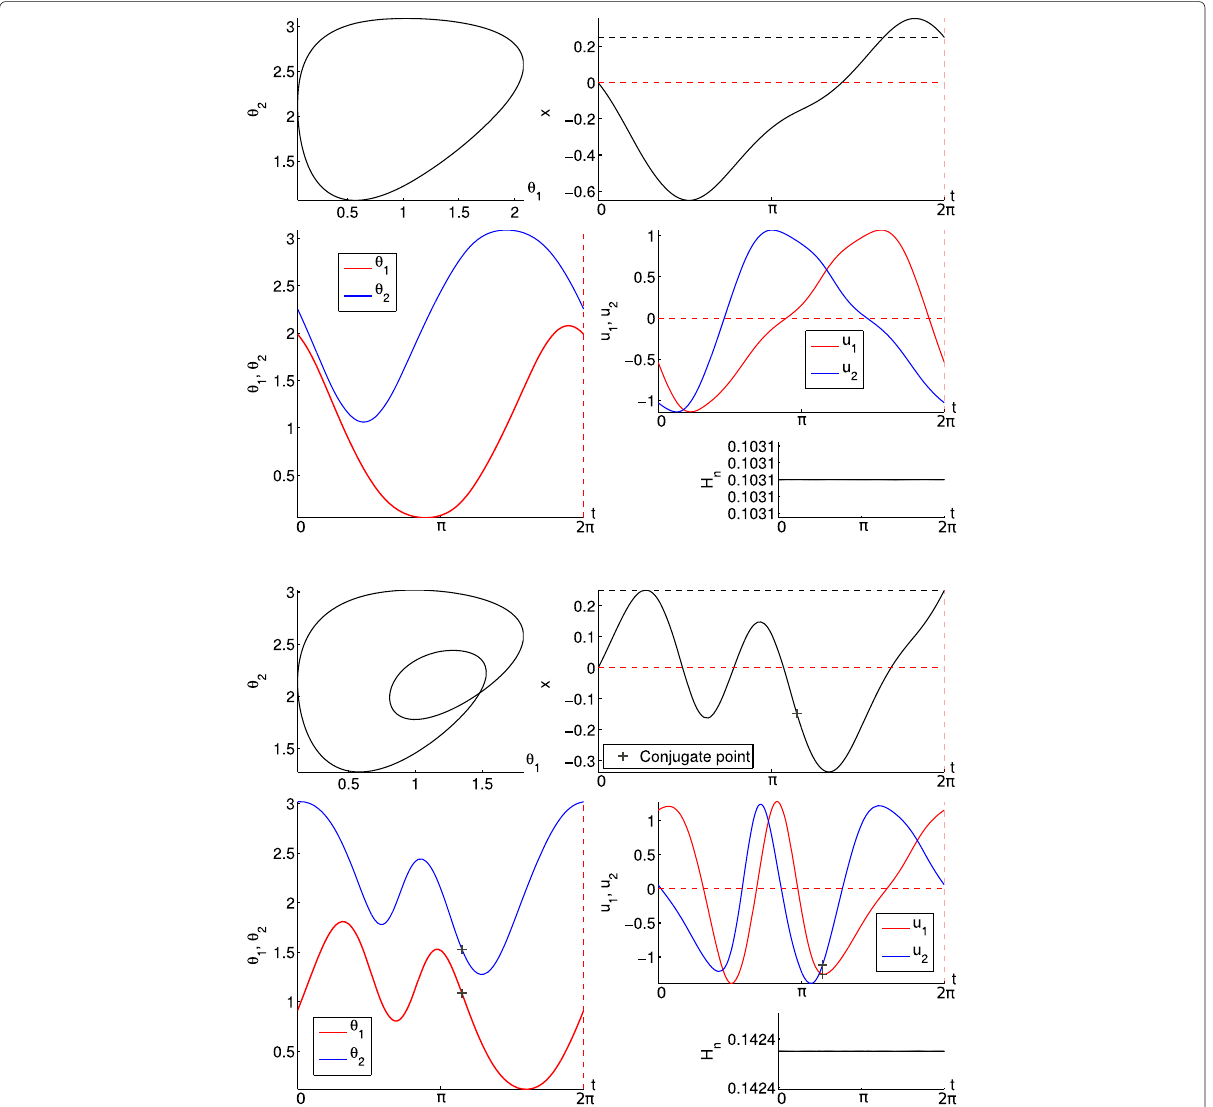
Fig. 7 Normal strokes: simple loop (top), limaçon with inner loop (bottom). First conjugate points on [0,2 π ] are computed with a svd test and they appear with a